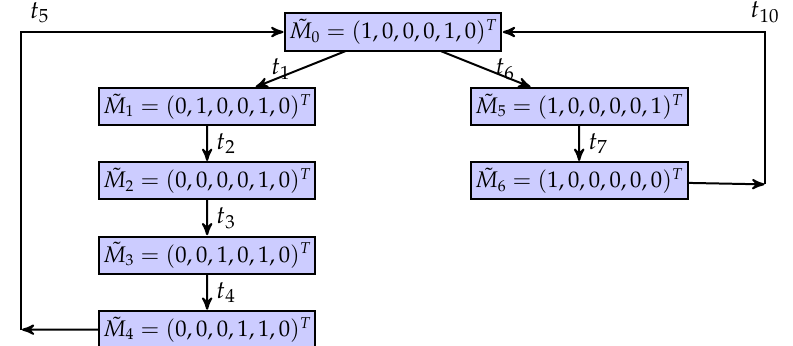
Figure 10. A coverability graph of the net system.